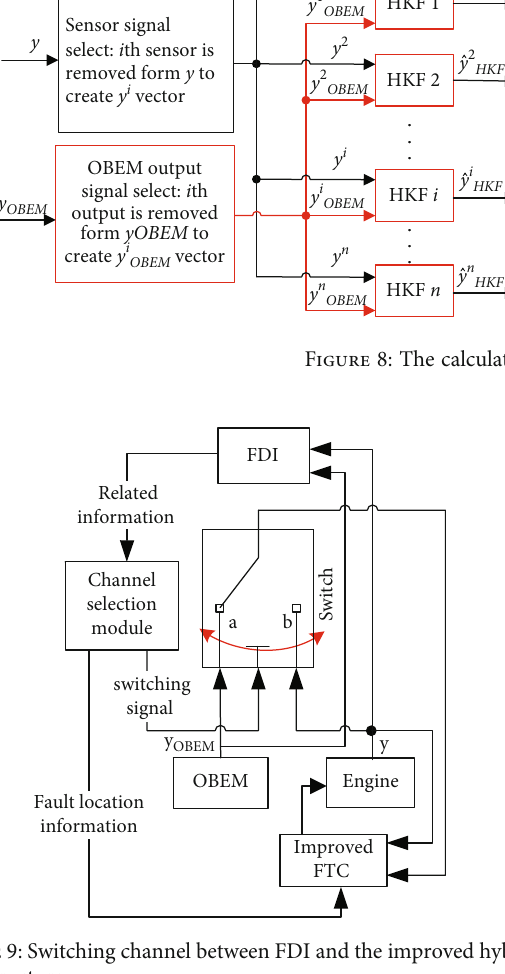
Figure 9: Switching channel between FDI and the improved hybrid FTC structure.